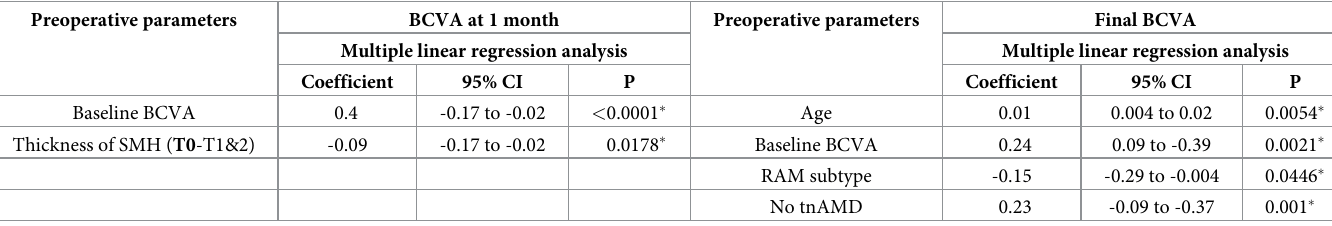
Table 4. Factors associated with BCVA in eyes with